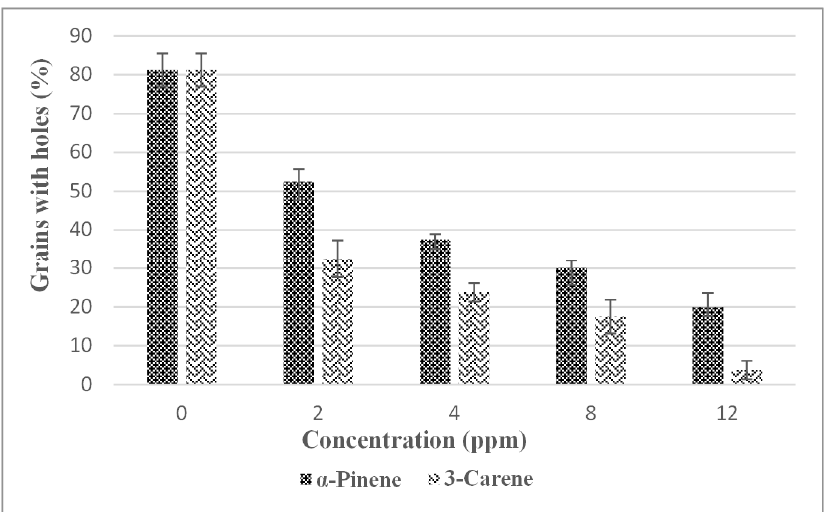
Figure 2. Inhibition of stored maize grain damage by Sitophilus zeamais due to treatment with α -pinene and 3-carene.